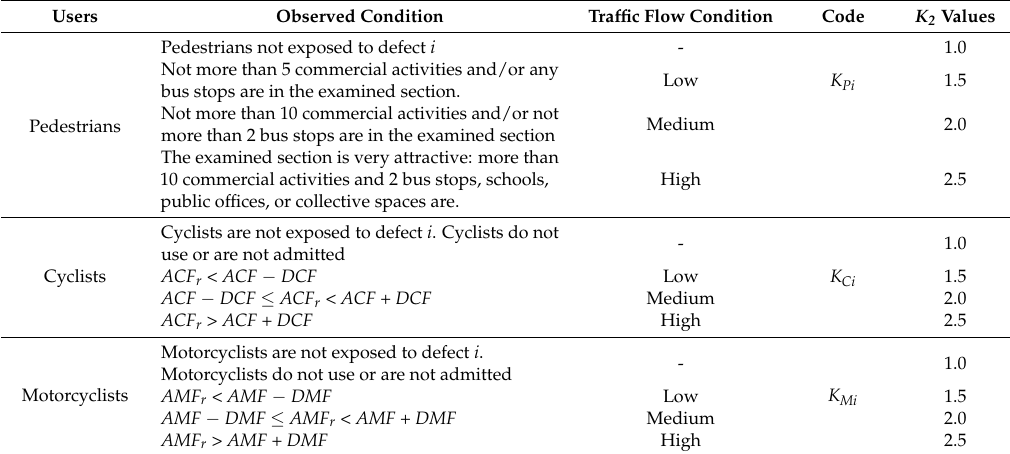
Table 3. Values of the vulnerability factor K 2i .